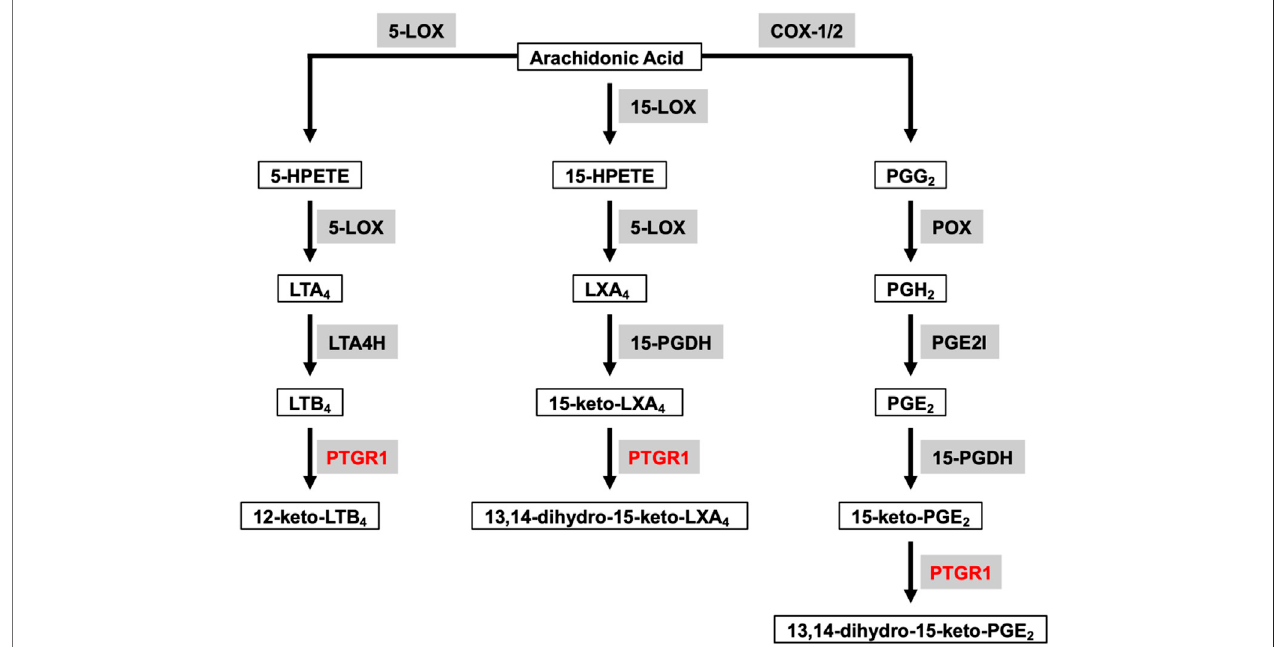
FIGURE1|OverviewofPTGR1functionanditsendogenoussubstrates. ArachidonicAcidcanbemetabolizedthroughCOXandLOXpathwaystogenerate eicosanoids, such as prostaglandins, leukotrienes and lipoxins. LTB 4 , 15-keto-LXA 4 , and 15-keto-PGE 2 are the direct substrates for PTGR1. Substrates are emphasizedwithblackbox. Enzymes areemphasizedingrey background and PTGR1 arecoloredwithred. 5-LOX, 5-lipoxygenase;15-LOX, 15-lipoxygenase;COX-1, cyclooxygenase-1; COX-2, cyclooxygenase-2; 5-HPETE, 5-hydroperoxyeicosatetraenoic acid; 15-HPETE, 15-hydroperoxyeicosatetraenoic acid; PGG 2 , PGH 2 , and